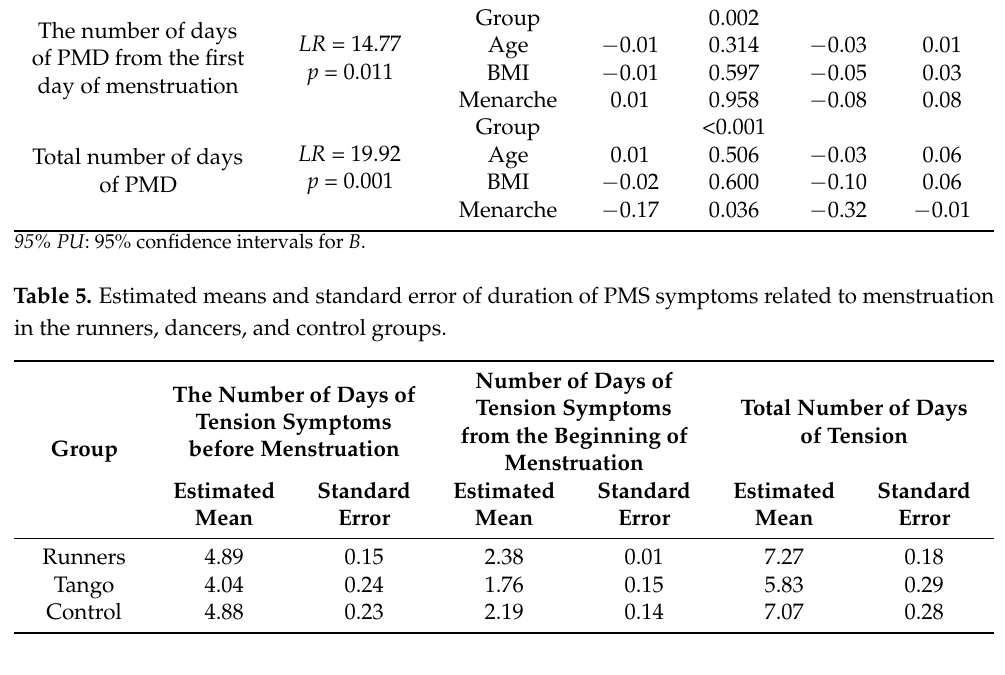
Table 6. Multiple logistic regression analysis of the predictors of the occurrence of PMS and individual symptoms of PMS. LR : likelihood ratio chi-square; p : significance level for LR; OR: odds ratio; 95% PU : 95% confidence intervals for odds